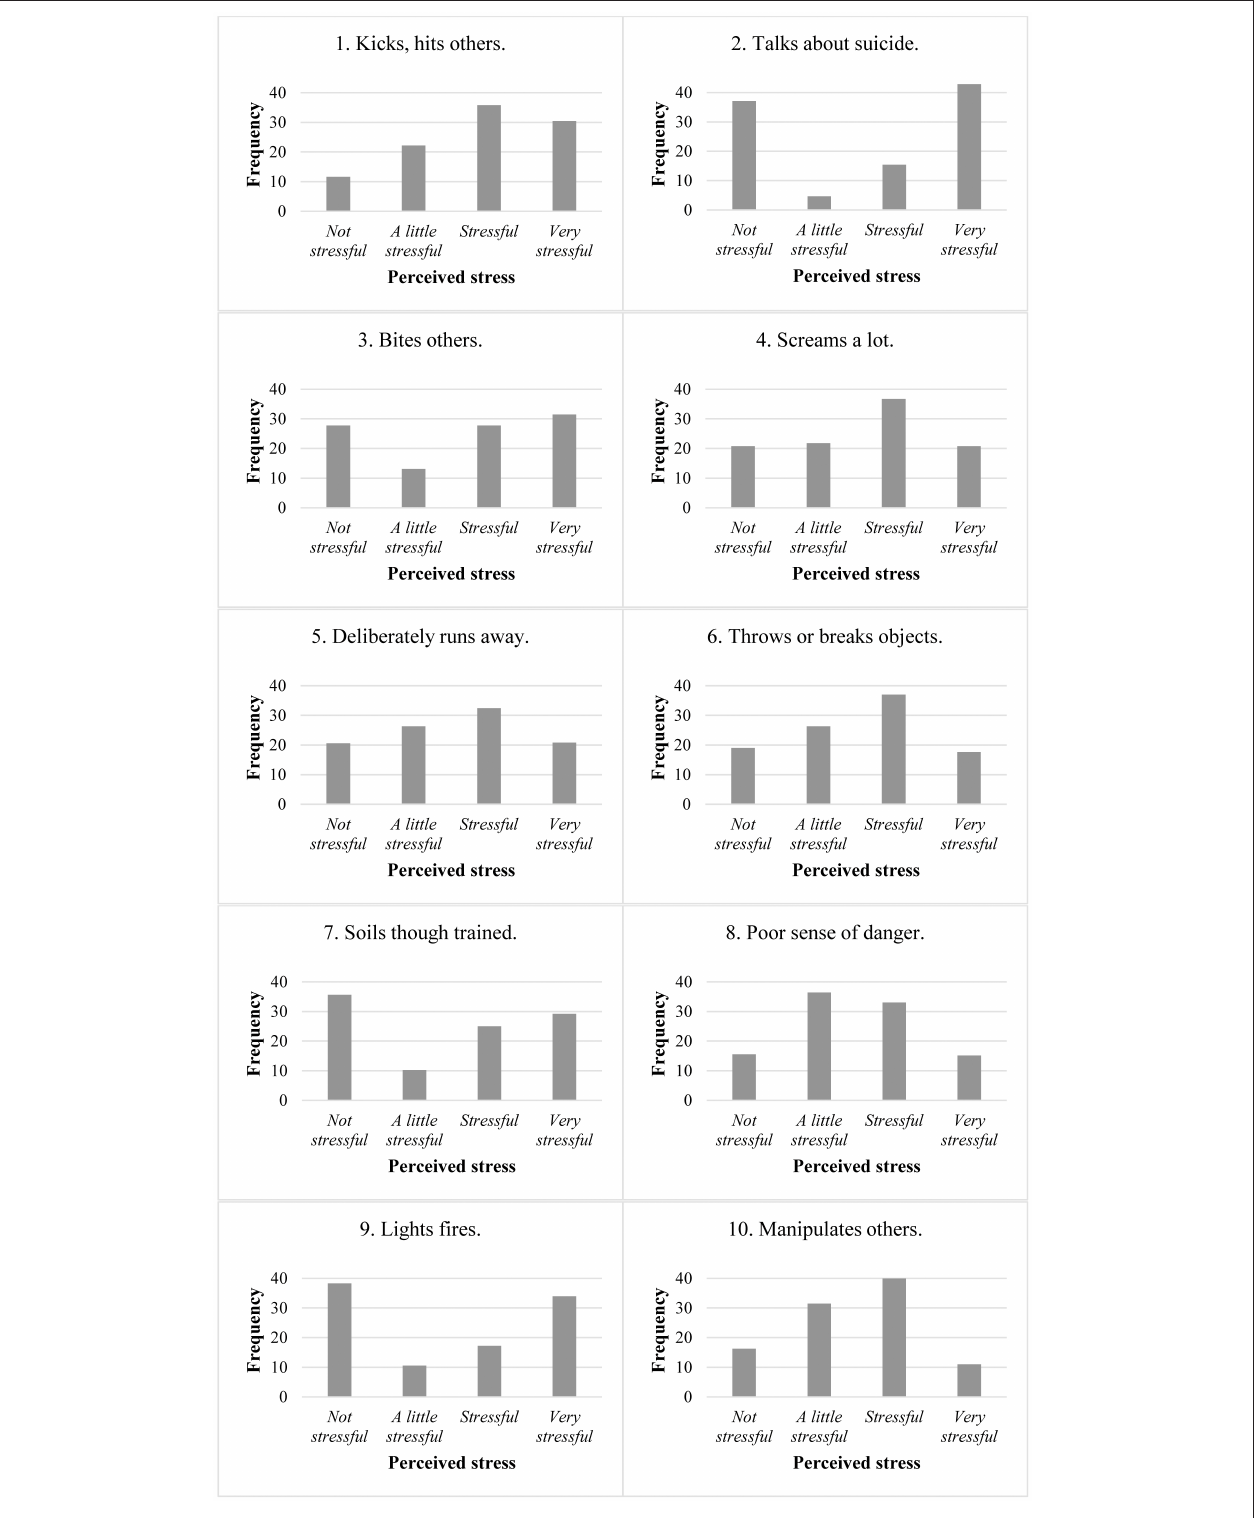
FIGURE 1 | Rating distributions of the 10 items on perceived stress due to the student problem behavior with the highest means.